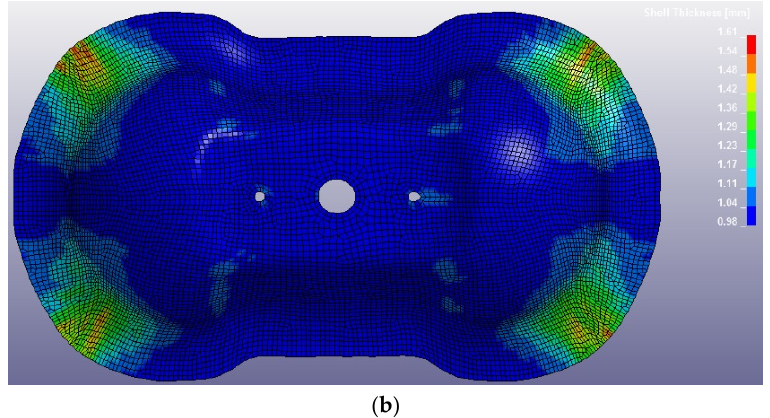
Figure 28. GF/PP Double Dome after thermoforming simulation: values of shear angle ( a ) and values of shell thickness ( b ).